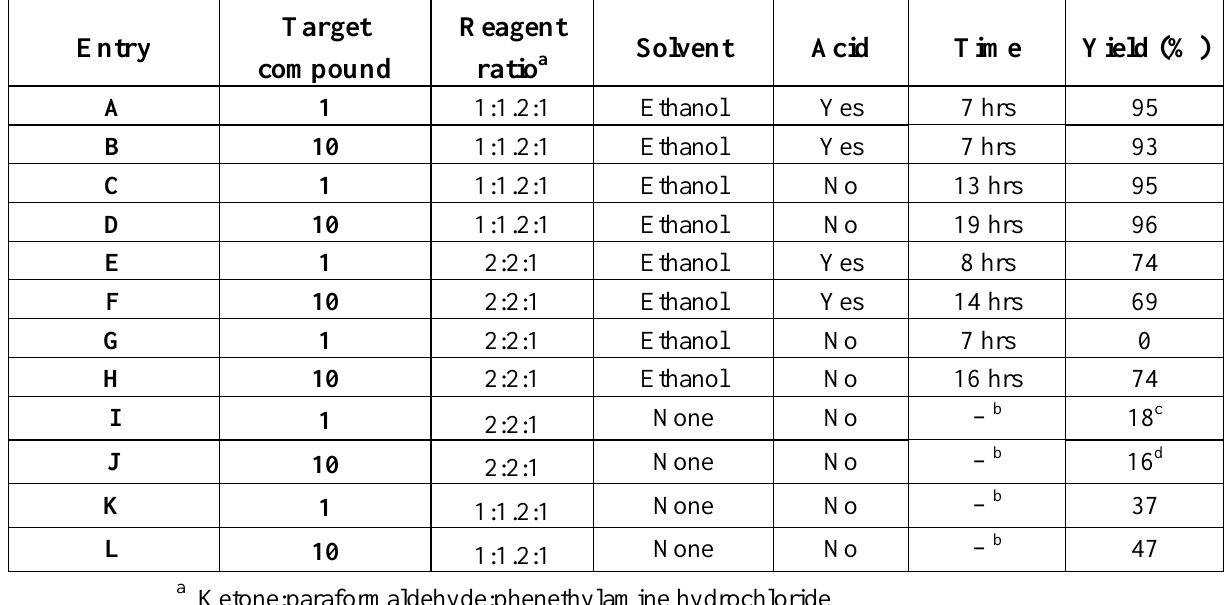
Table 3 . Optimization of reaction